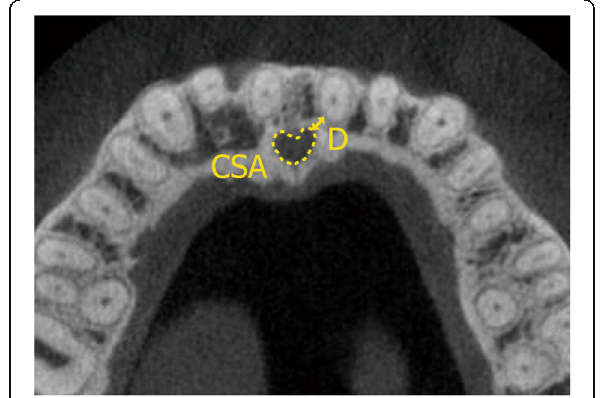
Fig. 4 Definitions of linear and area measurements in the horizontal plane. D distance from the left maxillary incisor to the incisive canal (mm); CSA , area of the incisive canal (mm 2